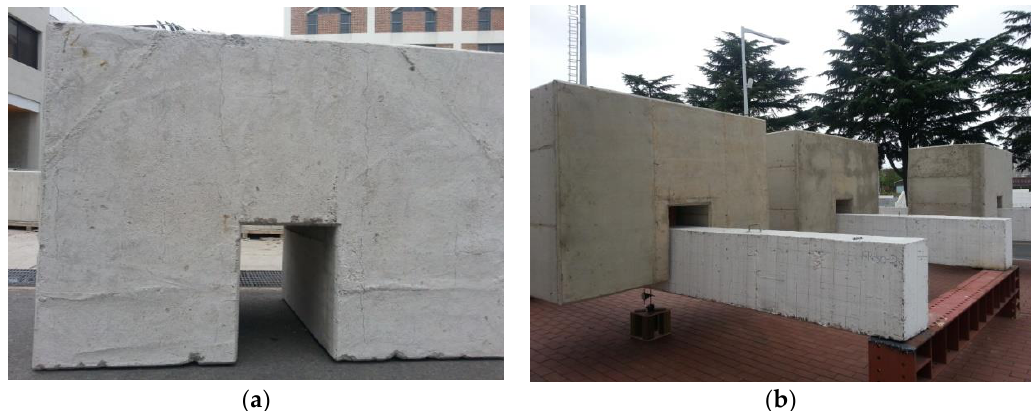
Figure 4. Long-term test setup: ( a ) loading mass; ( b ) test setup.